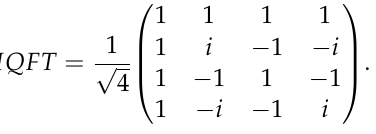
Figure 4. Circuit of the QWFRFT.